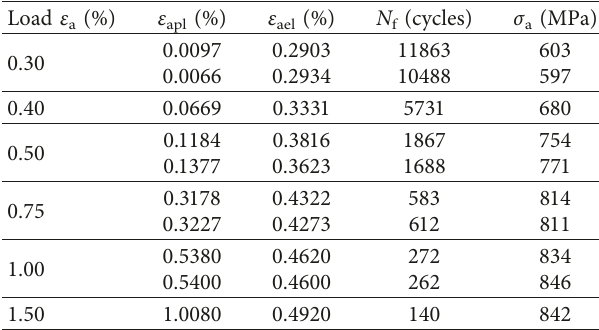
Table 3: Results of fatigue tests for S960QL steel. Load ε a (%)